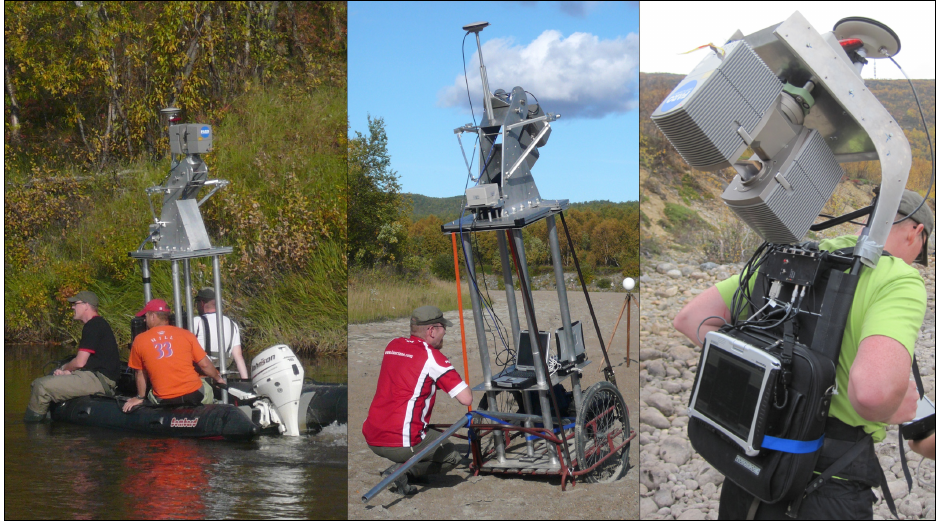
Figure 1. Different setups for the FGI ROAMER mobile mapping system: BoMMS ( left ); CartMMS ( centre ); Akhka ( right ).